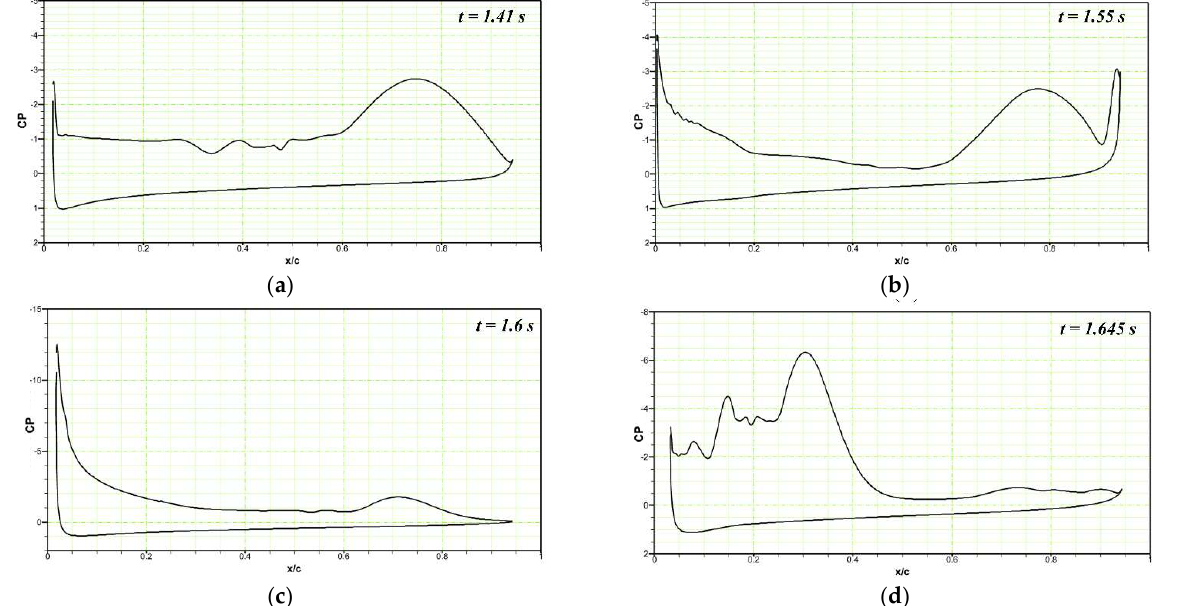
Figure 20. Pressure coefficient variations along the chord comparison of the reference airfoil with the DMLE airfoil at the angle of attack of 22° at the deflection frequency of 5 Hz for ( a ) time step of 1.41 s, ( b ) time step of 1.55 s, ( c ) time step of 1.6 s, ( d ) time step of 1.645 s. These figures reveal the pressure coefficients at different morphing leading edge deflections and also the deflection is faster at higher frequencies.